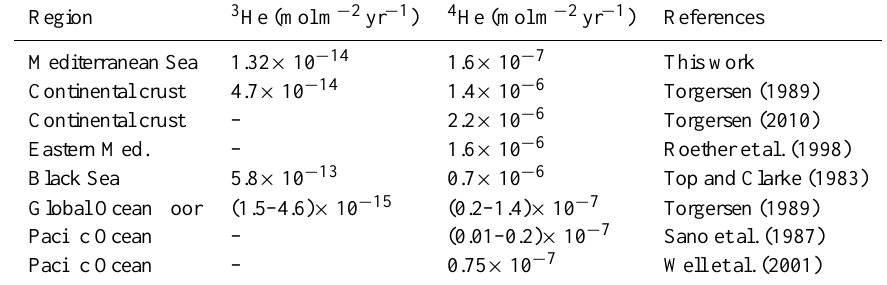
Table 2. Release rate of crustal helium used in the model and comparison with crustal helium fluxes in various geological